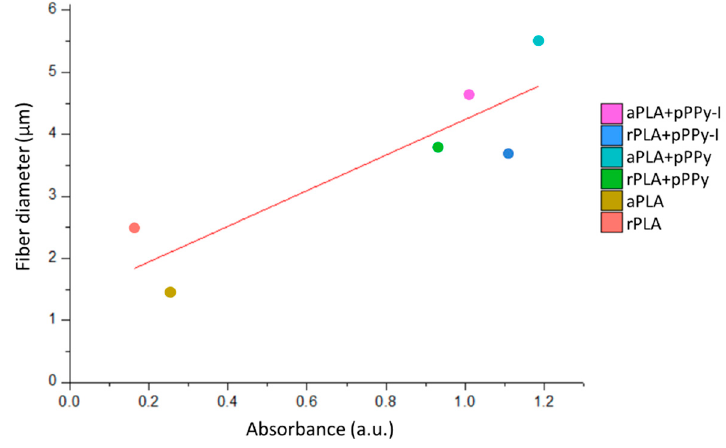
Figure 15. Effect of fiber diameter on cell viability. Linear correlation analysis showed a Person’s r of 0.88 between mean cell viability and mean fiber diameter.